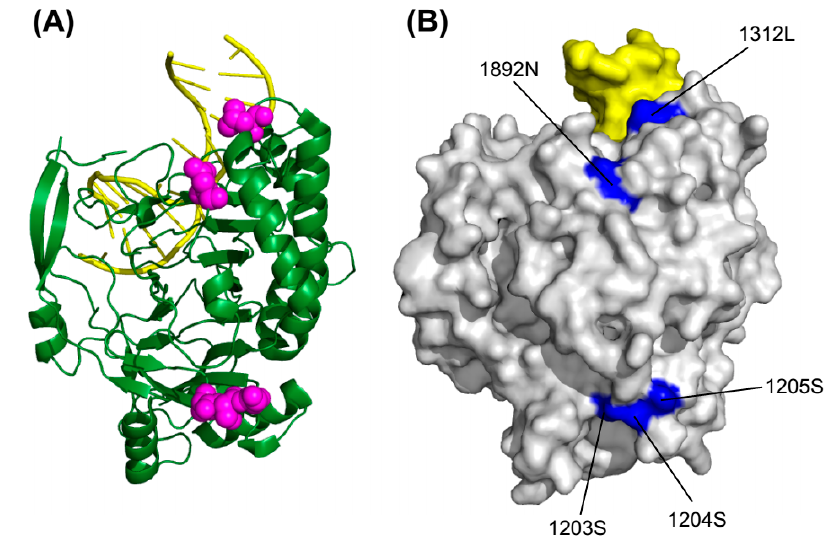
Figure 3. Sites under positive selection in the 3D structure of human TET2 catalytic core domain. ( A ) Ribbon representation of the human TET2 catalytic domain in complex with DNA duplex. The DNA is colored yellow. Five sites under positive selection are highlighted in the predicted structure with their side chains shown (magenta spheres); ( B ) Molecular surface representation of the human TET2 catalytic domain. The same five sites under positive selection are distributed on the molecular surface (accented in blue). The representations are in the same orientation.